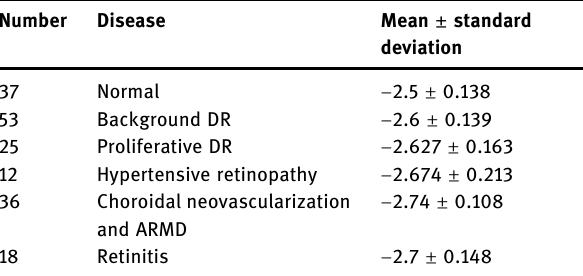
Table 6: Standard deviation and mean fractal dimension of retinal images with various diseases Number